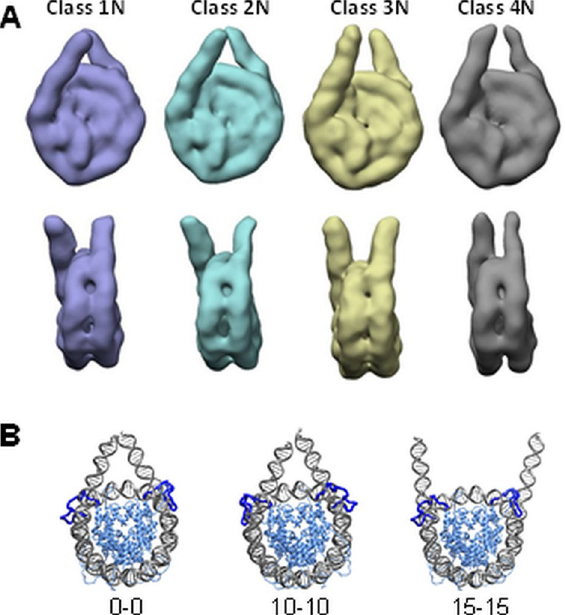
Figure 2. ( A ) 3D structure classification reveals diversified linker DNA geometry in the 177 bp nucleosome. Disk views of the four classes are displayed in the upper panel; side views are shown in the lower panel. ( B ). Molecular models of the 177 bp nucleosome, representing different degrees of DNA unwinding from the histone core. The numbers of the unwrapped DNA base pairs at the entry-exit sides are displayed below the corresponding structures. The long flexible N-termini of the two H3 histones that can extend and interact with linker DNA are highlighted in blue. The structure of the 147 bp NCP obtained from an MD simulation was used to build the snapshots. In the simulation, all histone tails collapse on the DNA as expected for the flexible oligocationic peptide tails at physiological salt conditions 95 . Physicochemical analysis 95 and experimental data 96–98 demonstrate that the H3 histone tails bind preferentially to the linker DNA, compared to the DNA of the NCP. The presence of the linker DNA allows tails extension and binding to this DNA. Structures were built and visualised using CHIMERA 83,84,94 (www.rbvi.ucsf.edu/chime